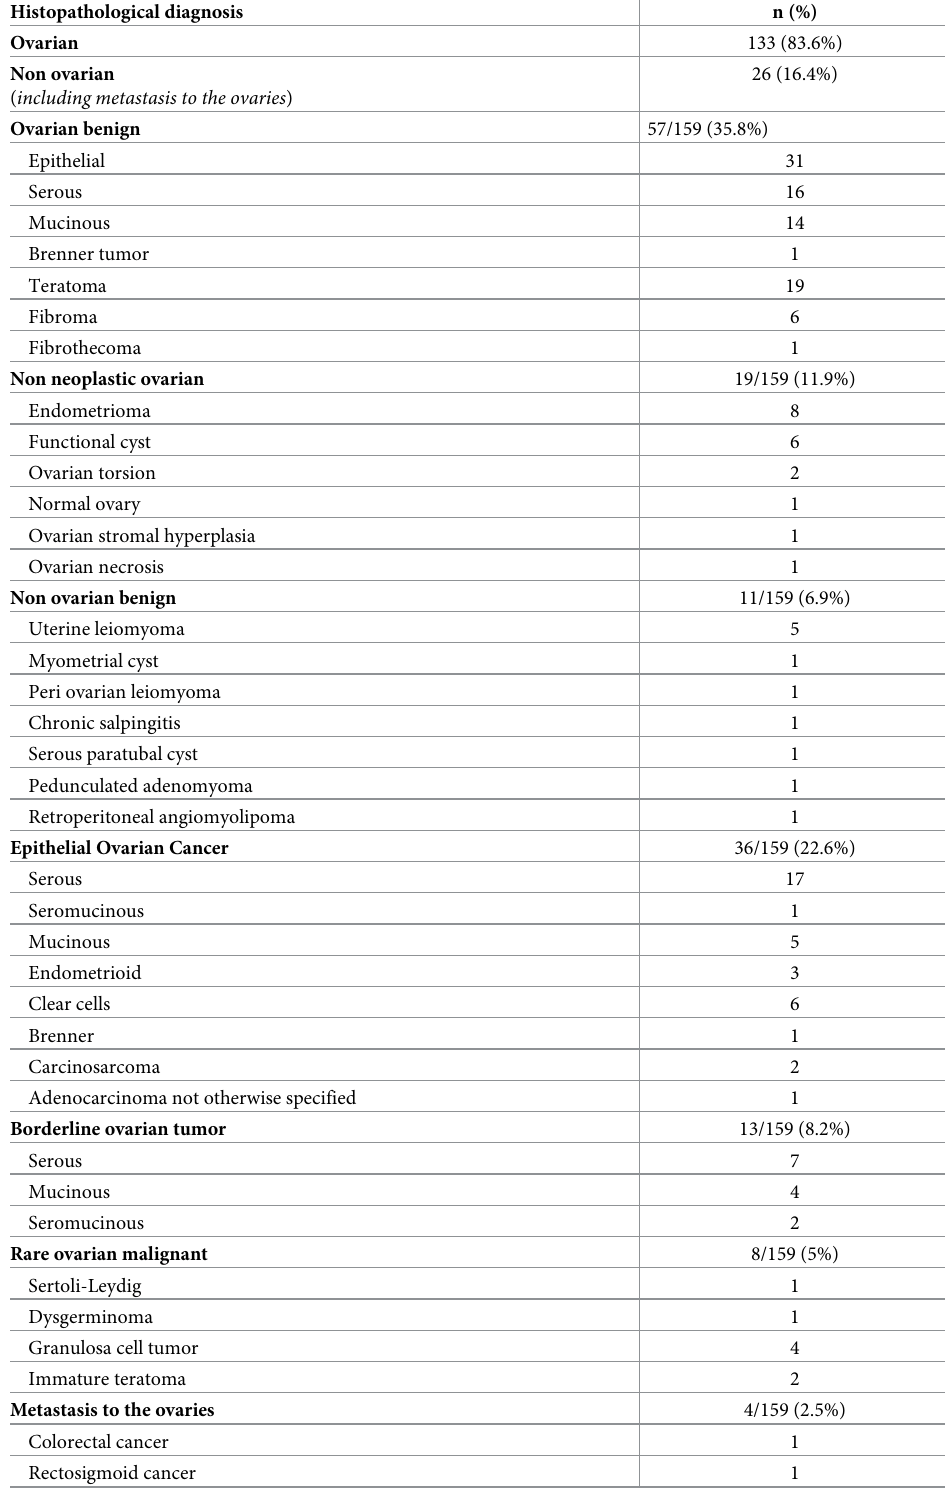
Table 2. Histopathological diagnosis of 159 study